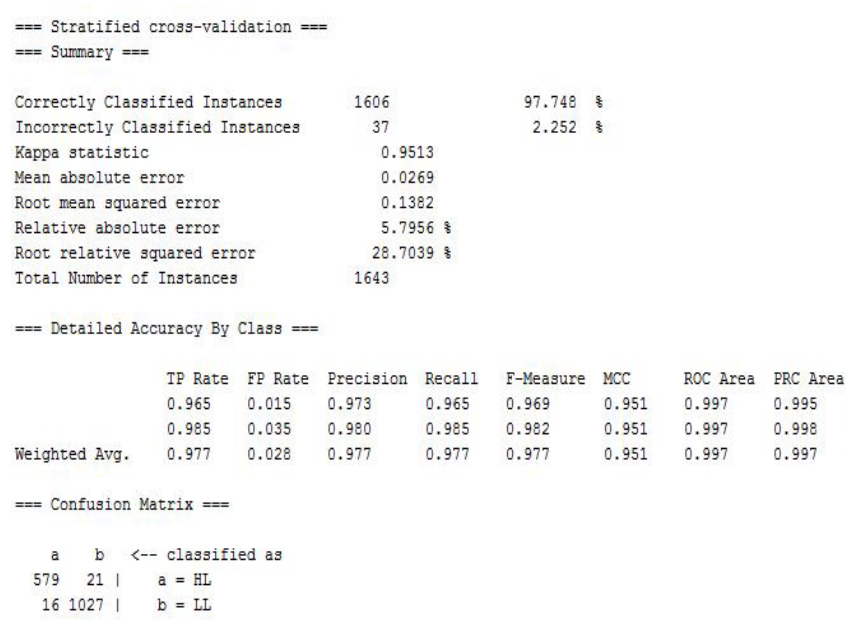
Table 7: Performance of MLP using 16 most relevant attributes dataset Item Value Metric Value Right All 1606 recall 0.985 Wrong All 37 specificity 0.965 Right HL 579 ROC curve 0.997 Wrong HL 21 F-Measure 0.982 Right LL 1027 kappa 0.9513 Wrong LL 16 RMSE